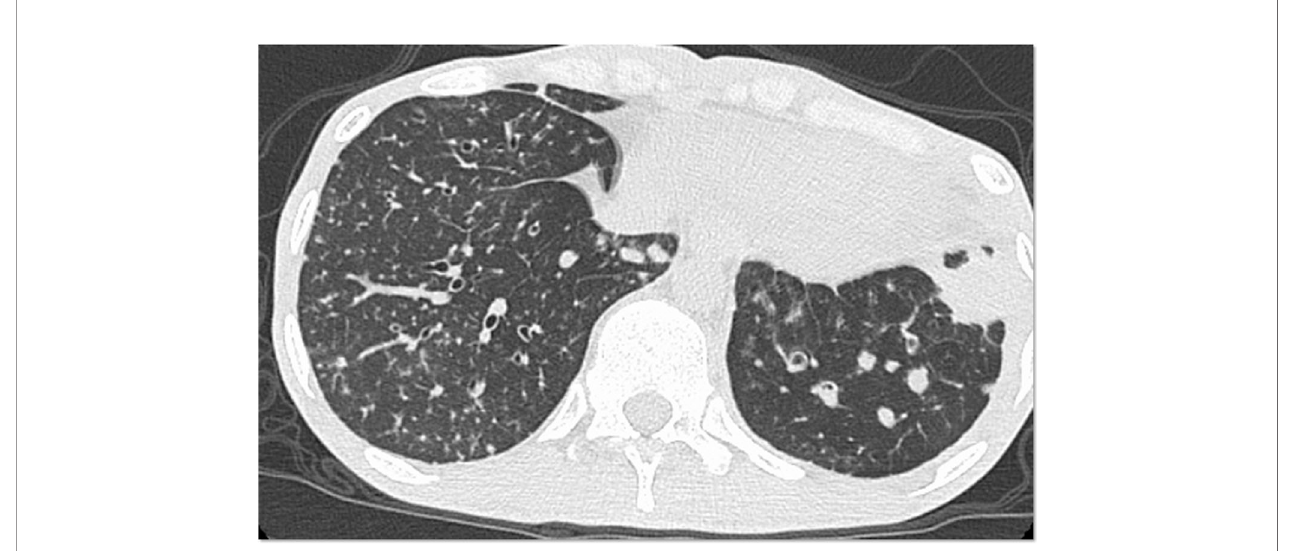
FIGURE 1 | Chest computed tomography scan. Bronchiectasis and multiple granular shadows are randomly distributed in the bilateral lobes, and consolidation in the lower left lobe is